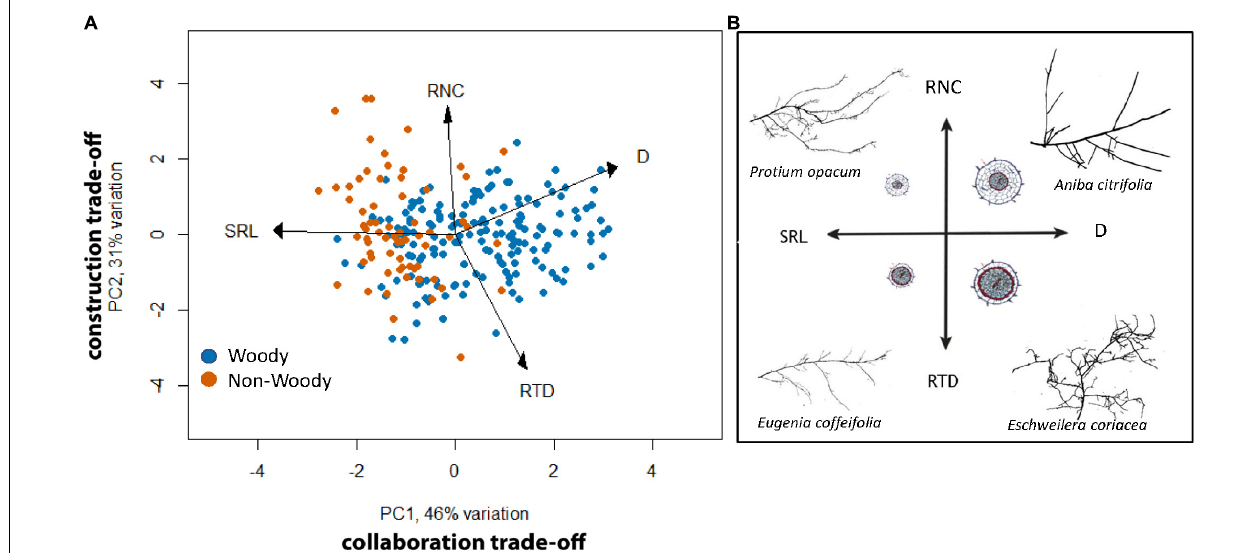
FIGURE 3 | Tradeoffs among fine root morphological traits and root N are shown for 240 tropical woody (blue) and non-woody (orange) species are show, with a conceptual representation of the possible relationship between root morphological/chemical traits and root anatomy. Panel (A) presents a principal component analysis (PCA) ordination of four commonly measured root morphological traits and nutrient content (specific root length, SRL; mean root diameter, D; root N content, RNC; root tissue density, RTD) for 240 tropical plant species. Axis 1 (PC1) explained 46% of the variation in fine root traits, with the strongest loadings by SRL ( − 3.6) and D (3.2). Axis 2 (PC2) explained 31% of the remaining variation, with the strongest loadings by RTD ( − 1.3) and RNC (0.04). Panel (B) illustrates the possible variation in anatomical traits that explains the variation in morphological traits and N content. Species with larger cortical tissue (clear areas in the root cross section) likely have greater N content, whereas greater vascular stele (gray areas) likely increase tissue density. Fine root diameter and SRL should therefore be a function of the ratio between cortical and stele tissue. Root systems in panel (B) exemplify the natural variation in tropical species within the conceptual frame. Figure modified from Valverde-Barrantes et al.